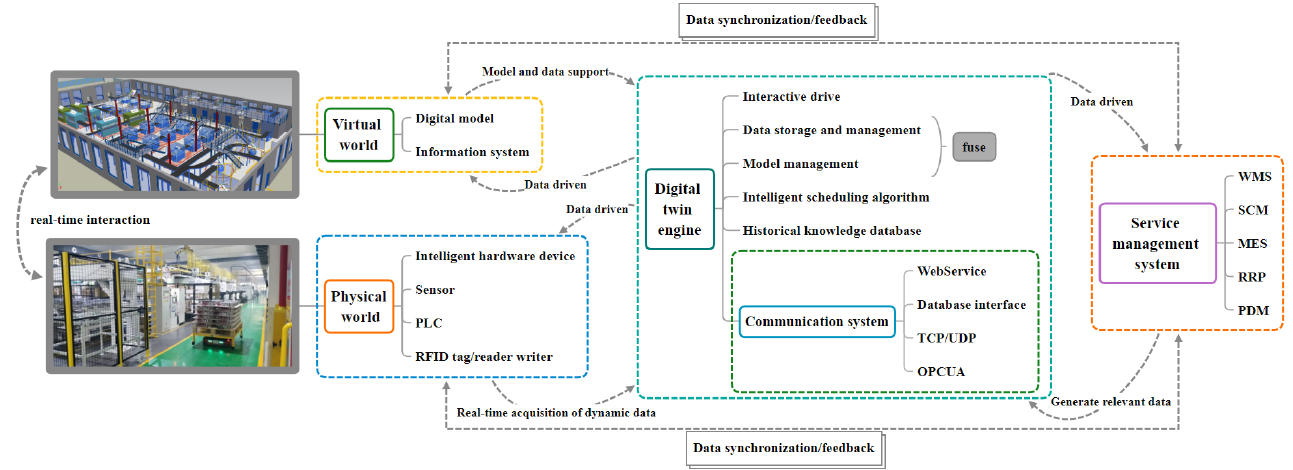
Figure 1. Dynamic scheduling architecture of a workshop logistics system.